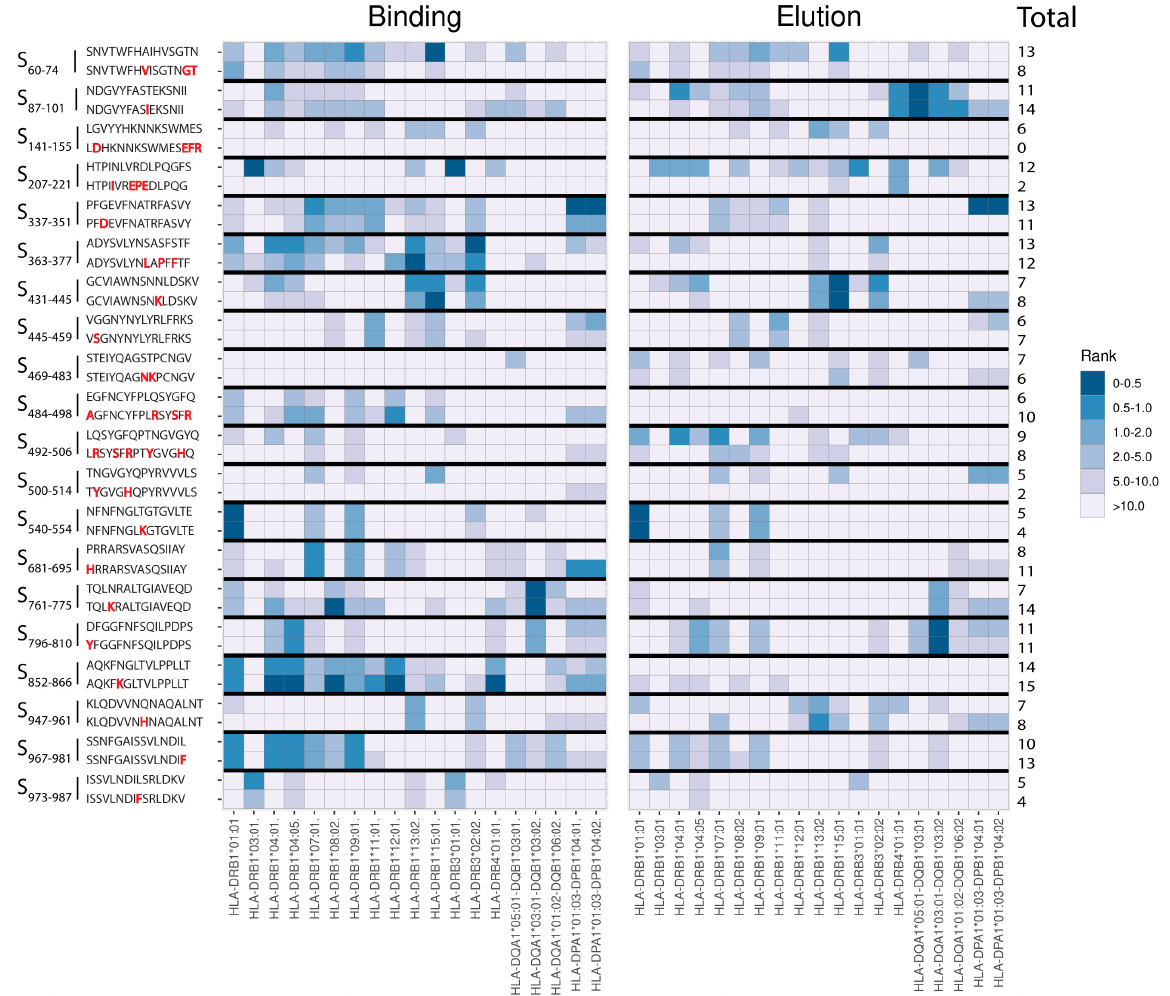
Figure 1. Heatmap showing predicted T cell immunogenicity scores of selected epitope candidates for multiple common HLA-II alleles. Predicted T cell immunogenicity scores of the CD4 + T-cell epitope candidates of the spike protein of the D614G wild-type (WT) SARS-CoV-2 strain were plotted next to the scores of the corresponding Omicron BA.1 variant peptides having single or multiple mutations (including insertions/deletions). Color scale in heat map indicates differences in predicted HLA-II binding affinity scores ( left panel ) or elution scores ( right panel ) to the various HLA-II alleles as depicted below. Peptides with lower rank scores (dark blue) represent strongly predicted T-cell epitopes. Each peptide pair is indicated as location of first and last amino acid position within WT spike protein (S), the WT spike sequence is presented on top and the Omicron BA.1 spike sequence below it. Differences in amino acid sequences between the Omicron BA.1 peptides compared with the epitope candidates of the WT ancestral spike are marked in red. On the right side of the figure, for each peptide the total number of HLA-II alleles is indicated that had a % rank score < 10.0 for either binding affinity prediction or elution % rank score <